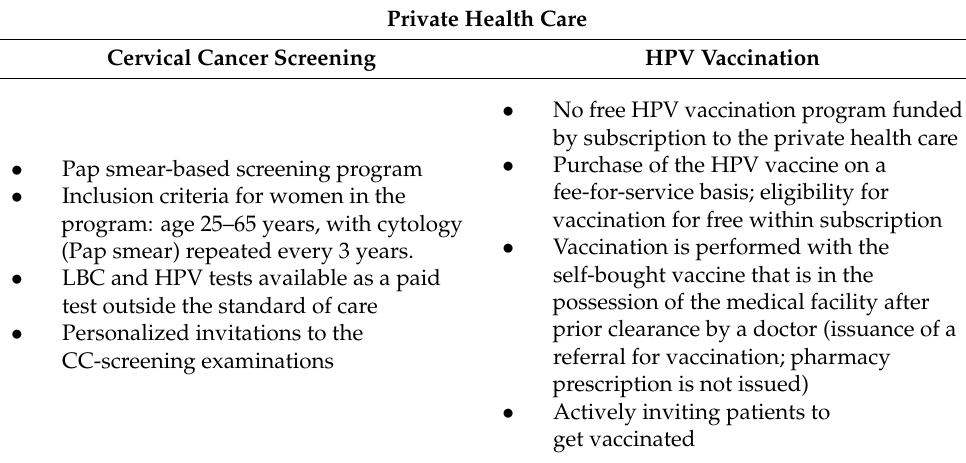
Table 2. The principles of CC prevention in private health care in